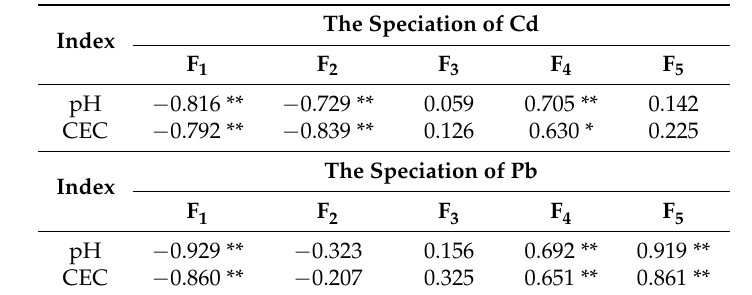
Table 3. Correlation analysis among the speciation of typical potential toxic metals (PTMs), pH value and